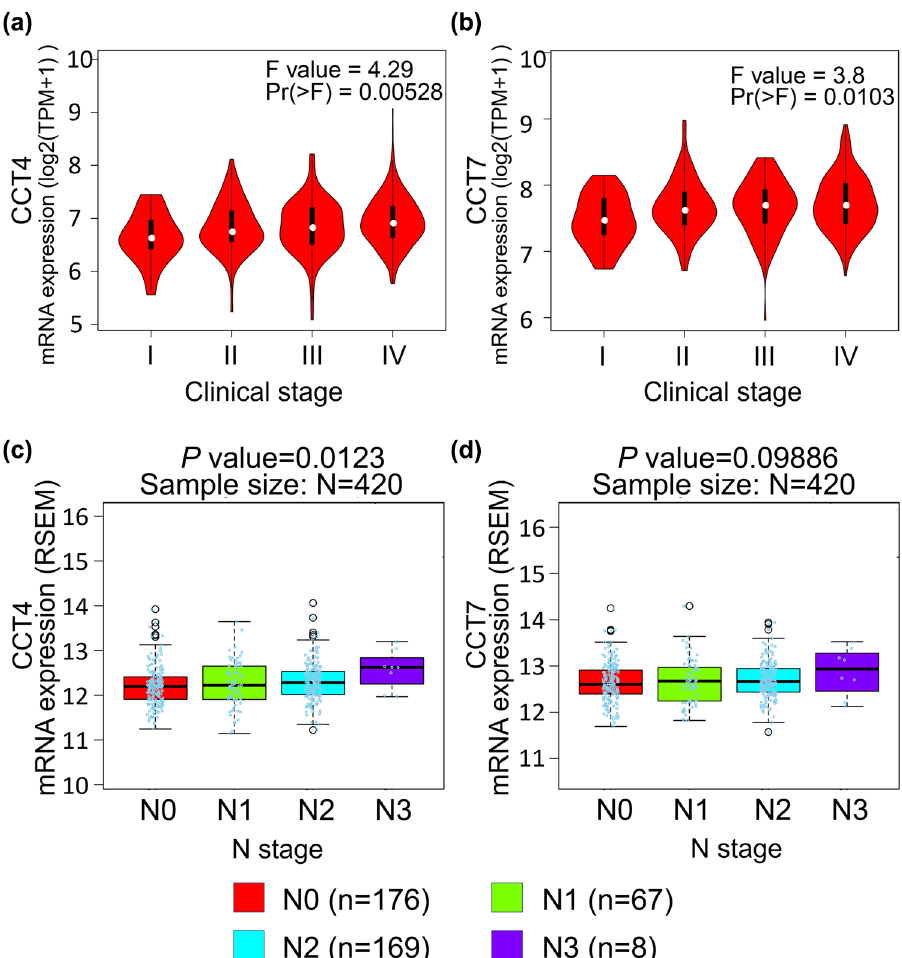
Figure 3: Correlation between the CCT4/7 expression and tumor stage in HNSC patients ( GEPIA and LinkedOmics ) . ( a and b ) Violin plots showing the relative expression of CCT4/7 in HNSC patients in stage I, II, III, or IV. ( c and d ) Boxplots indicating the relative expression of CCT4/7 in HNSC patients with N stage of 0, 1, 2, or